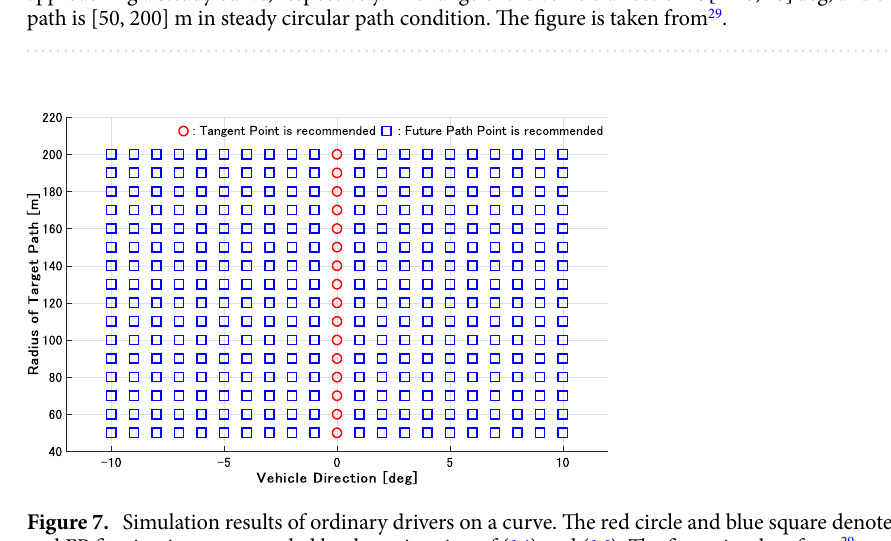
Figure 6. Simulation conditions. ( A ) and ( B ) show environments of a steady circular path and a straight path approaching a steady curve, respectively. The range of the vehicle direction is [− 10, 10 ] deg, and the radius of the path is [50, 200] m in steady circular path condition. The figure is taken from 29 .